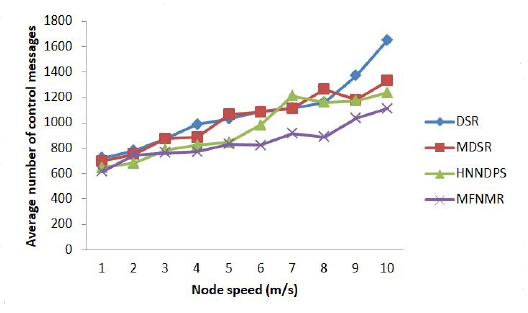
Figure 10. Routing Overhead Analysis based on Node